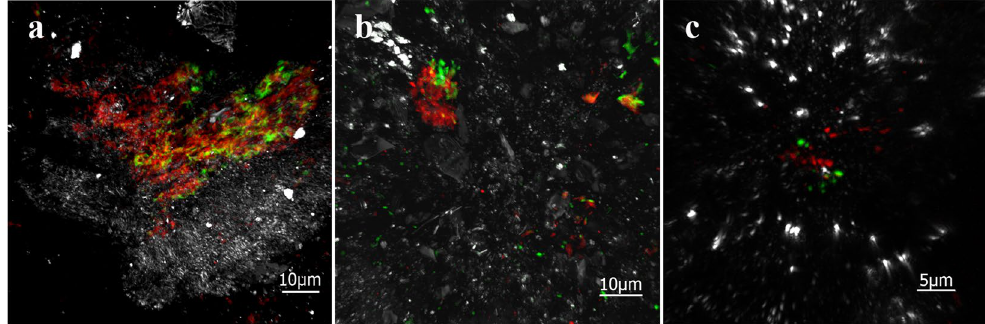
Figure 5. Double CARD-FISH detection of bacterial and archaeal mixed colonies in drilled samples from different depts. Double CARD-FISH with bacteria probe (green) and archaea probe (red) at ( a ) 139, 4 mbs, ( b ) 284 mbs and ( c ) 414, 8 mbs. Scale bars, a and b 10 μ m, c 5 μ m.